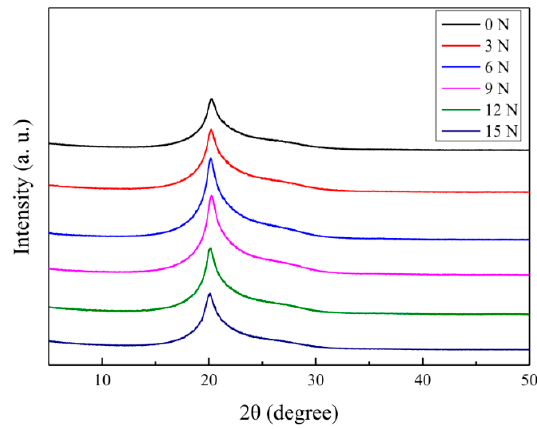
Figure 8. XRD spectra of the aramid fiber after treated with 1,4-dichlorobutane in scCO 2 under